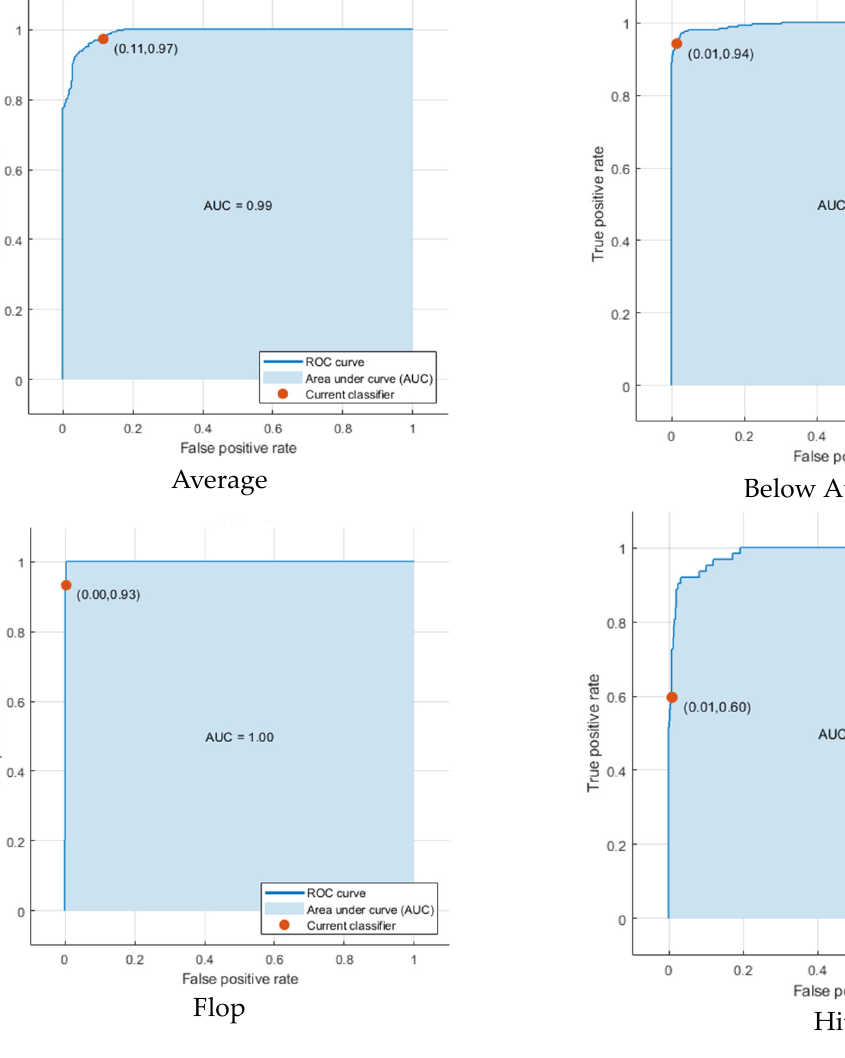
Figure 7. Weighted KNN ROC.